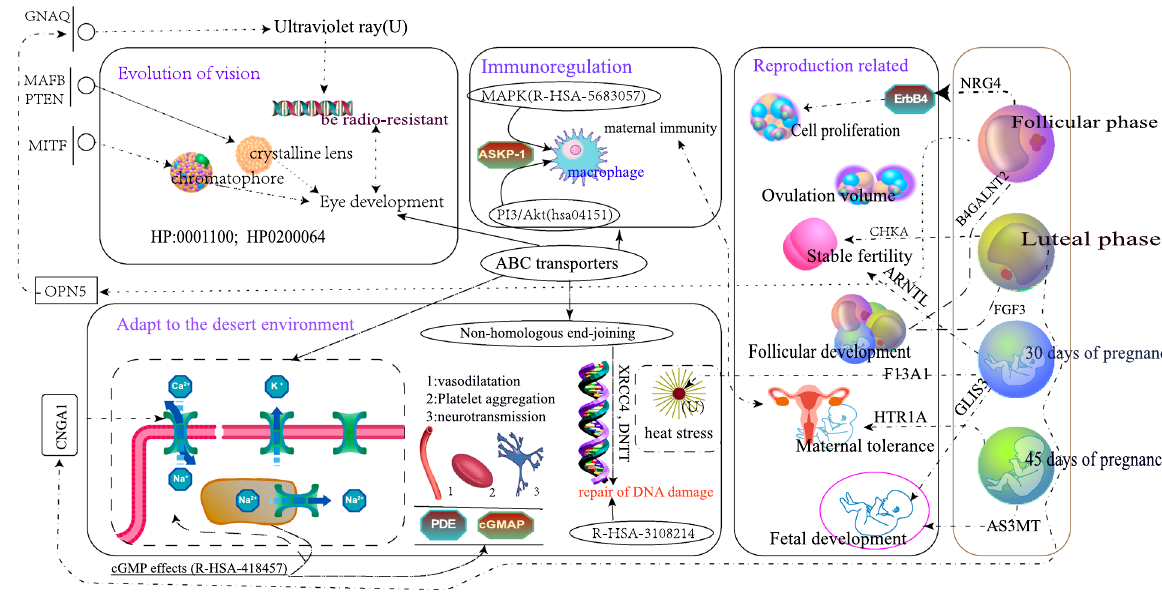
Figure 11. Environmental adaptability and perennial estrus regulatory network of the Taklimakan Desert sheep